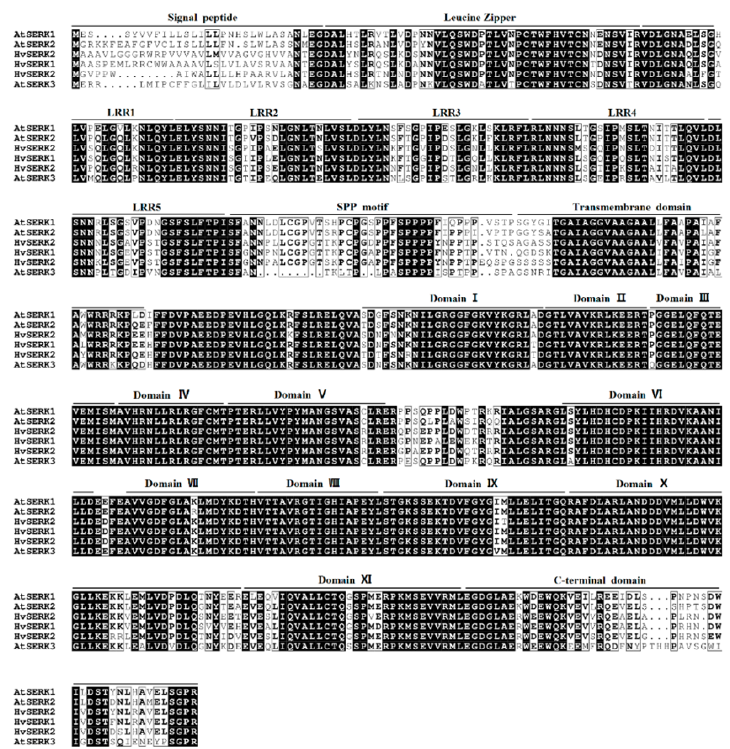
Figure 1. Comparison of three somatic embryogenesis receptor-like kinase (SERK) proteins from Hordeum vulgare L. and Arabidopsis thaliana SERK1, SERK2, and SERK3 proteins. Putative domains are indicated at the top of the sequences. The 11 subdomains of the protein kinase domain are marked with Roman numerals.